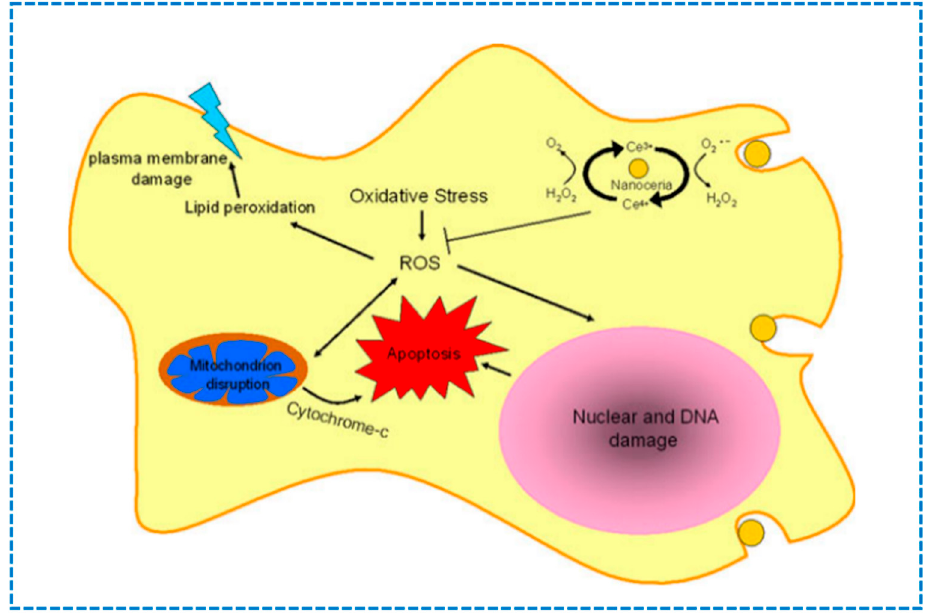
Figure 4. Antioxidant mechanism of nanoscale cerium oxide [29]. Copyright 2013 MDPI AG.